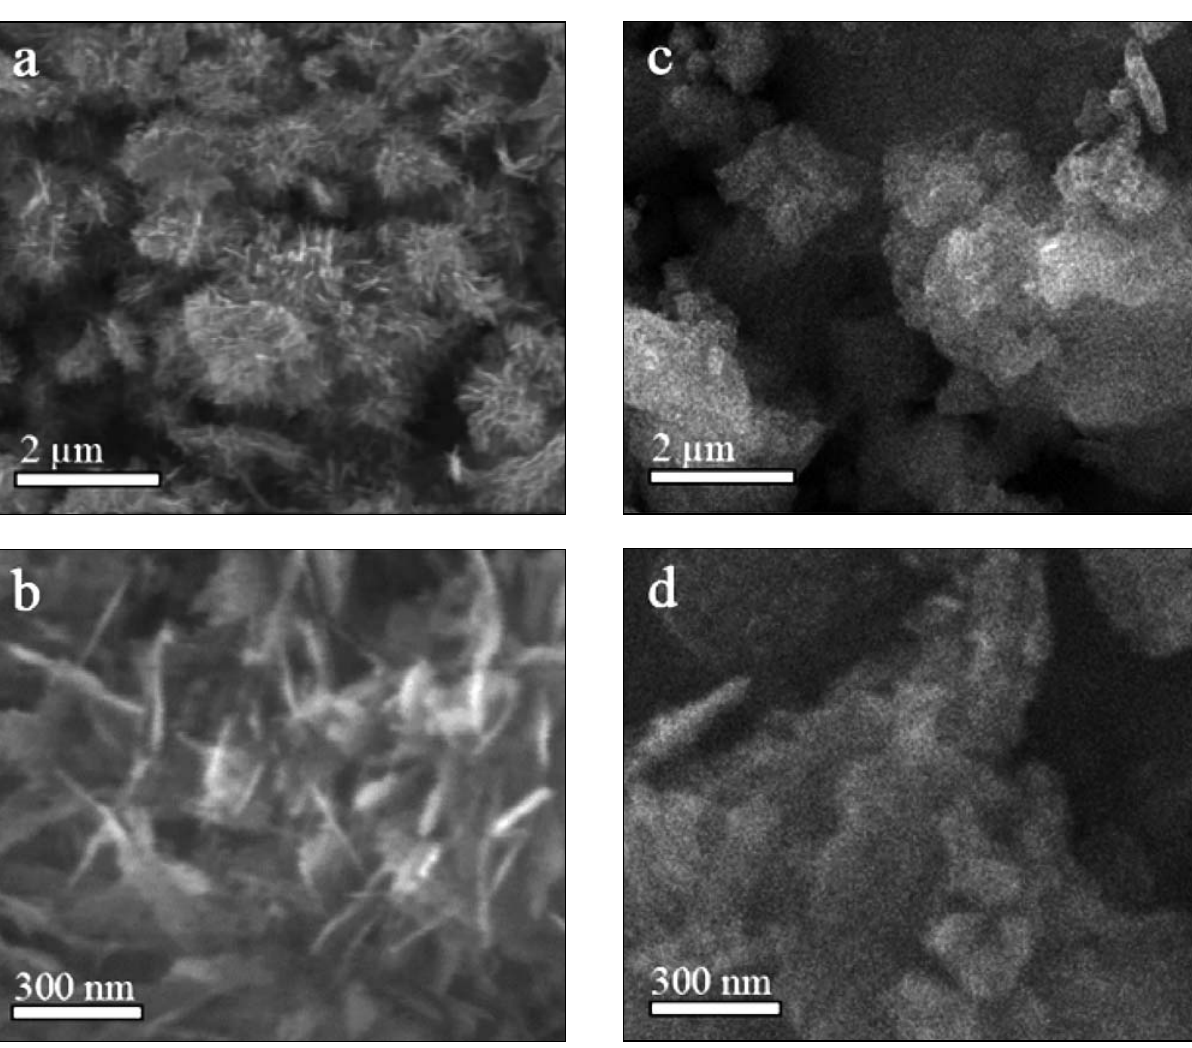
Figure 3. SEM micrographs of (a,b) ZnO, and (c,d) 20CuO/ZnO